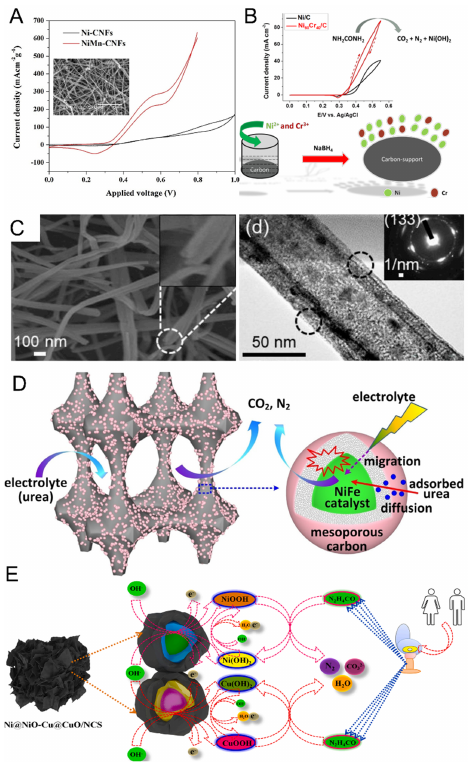
Figure 4. ( A ) Cyclic voltammograms for Ni – CNFs and NiMn – CNFs at 1.0 M urea concentration in 1.0 M KOH [69]. Reproduced with permission [69]. Copyright 2015, Elsevier B.V. ( B ) TOC of UOR on NiCr catalysts in alkaline electrolyte [78]. Reproduced with permission [78]. Copyright 2017,